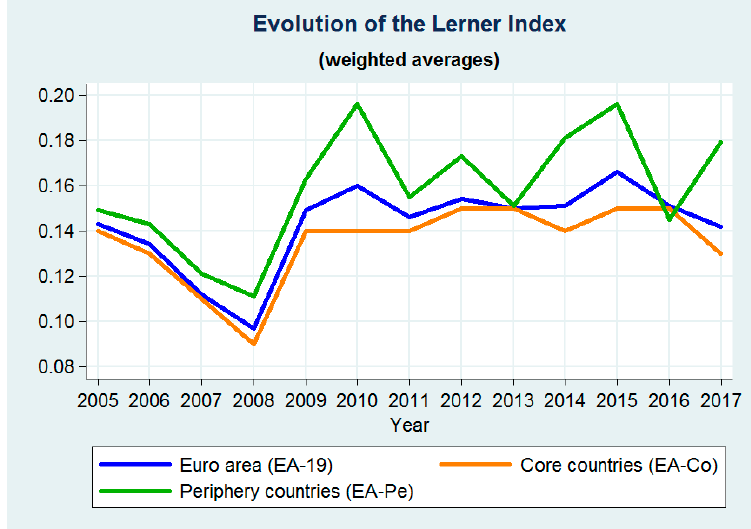
Figure 1. Evolution of the Lerner index of market power. Source: BankScope database, own calculations.